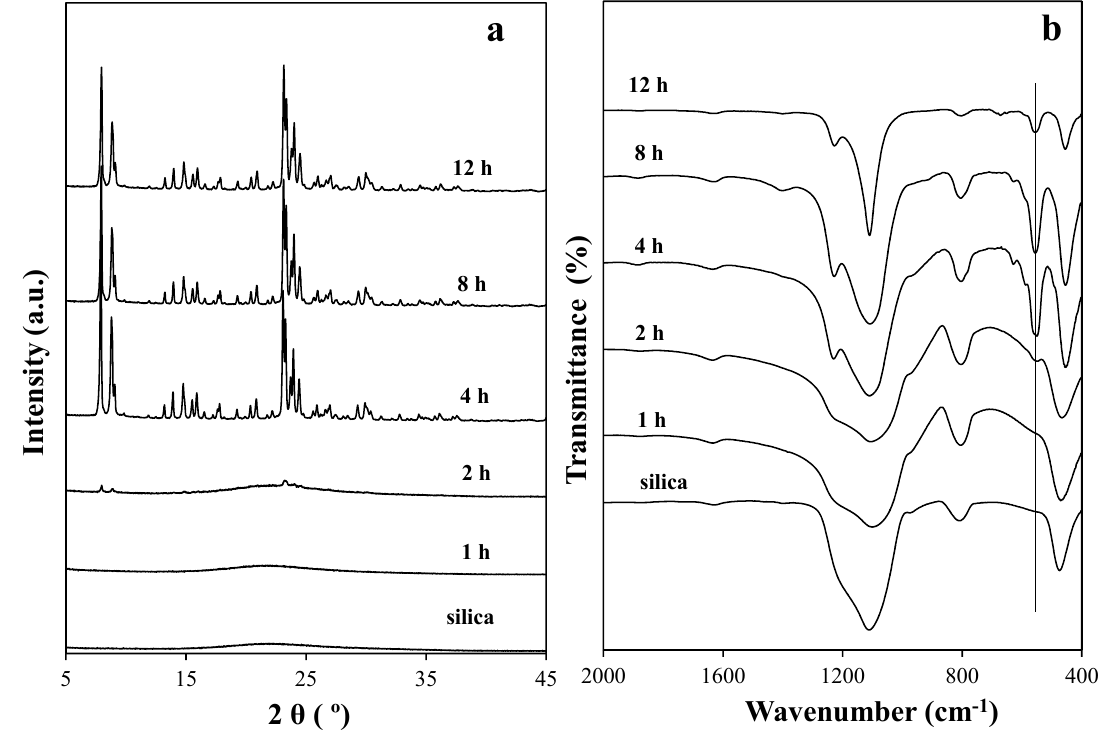
Figure 1. The XRD pattern ( a ) and FT-IR spectra ( b ) of silicalite-1 synthesized from silica with particle size of 12 nm.